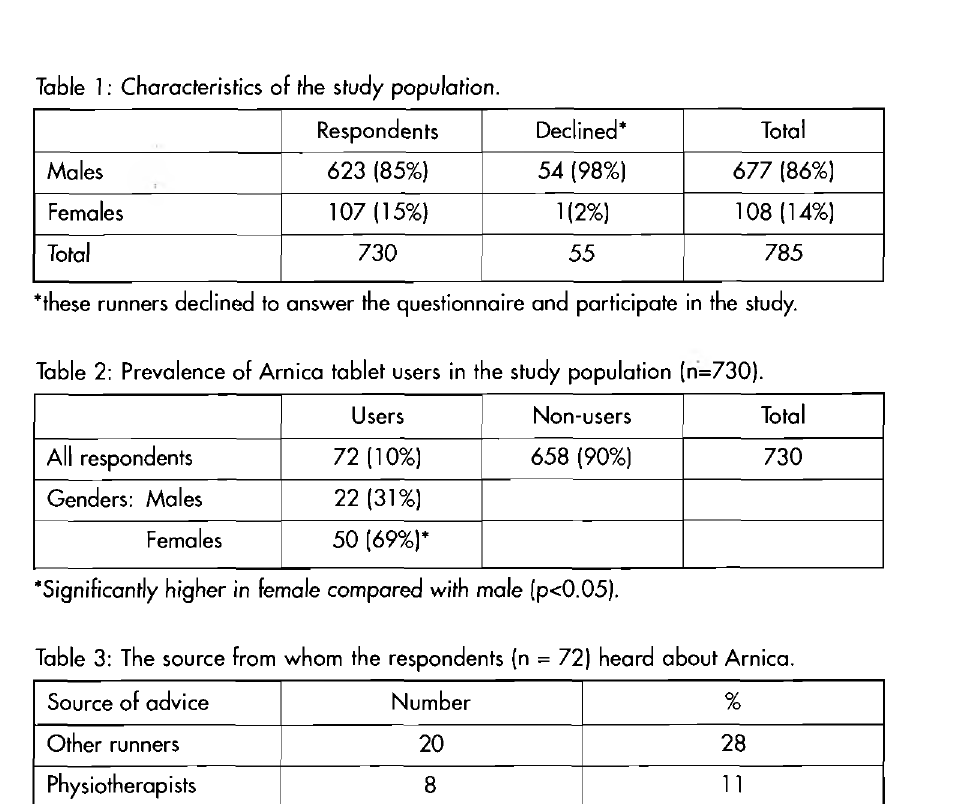
Table 1: Characteristics of the study population.